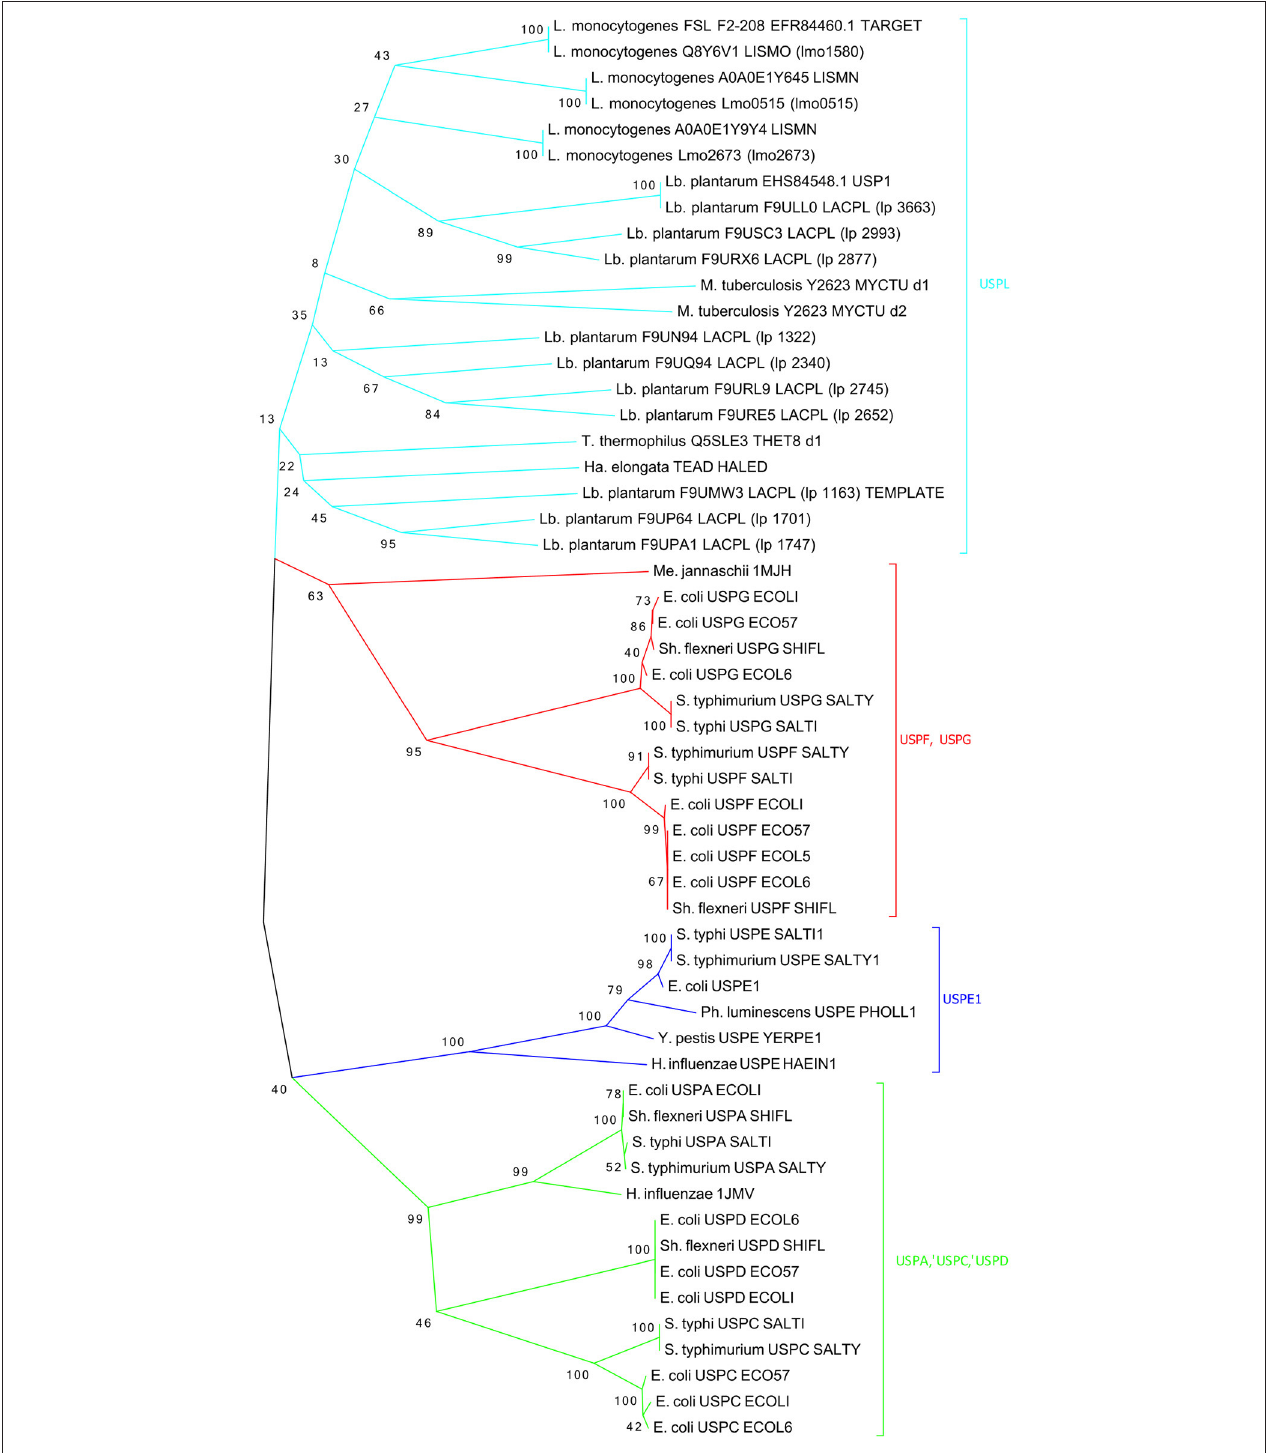
FIGURE 5 | Phylogenetic tree of the 55 most characterized USPs. Bacterium genus are indicated: (L.), Listeria ; (Lb.), Lactobacillus ; (S.), Salmonella ; (Sh.), Shigella ; (Y.), Yersinia ; (Ph.), Photorhabdus ; (E.), Escherichia ; (H.), Haemophylus ; (Ha.), Halomonas ; (T.), Thermus ; (M.), Mycobacterium ; (Me.), Methanococcus .